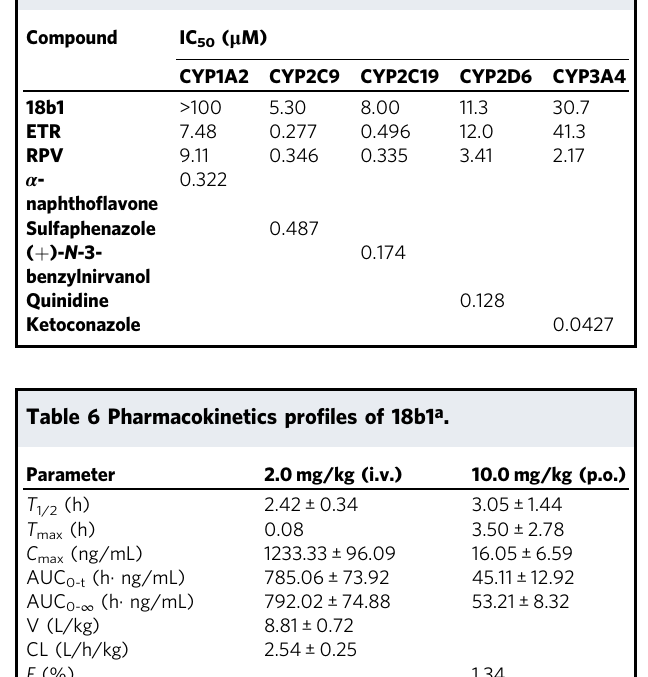
Table 5 Effects of 18b1 on inhibition of CYP1A2, CYP2C9, CYP2C19, CYP2D6 and